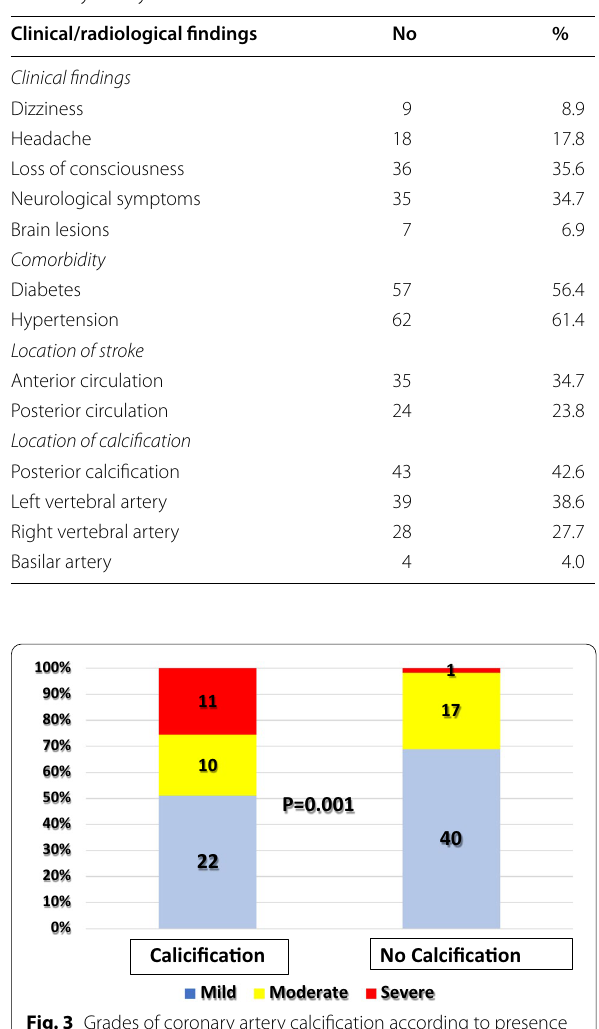
Table 2 Clinical and radiological findings of patients with